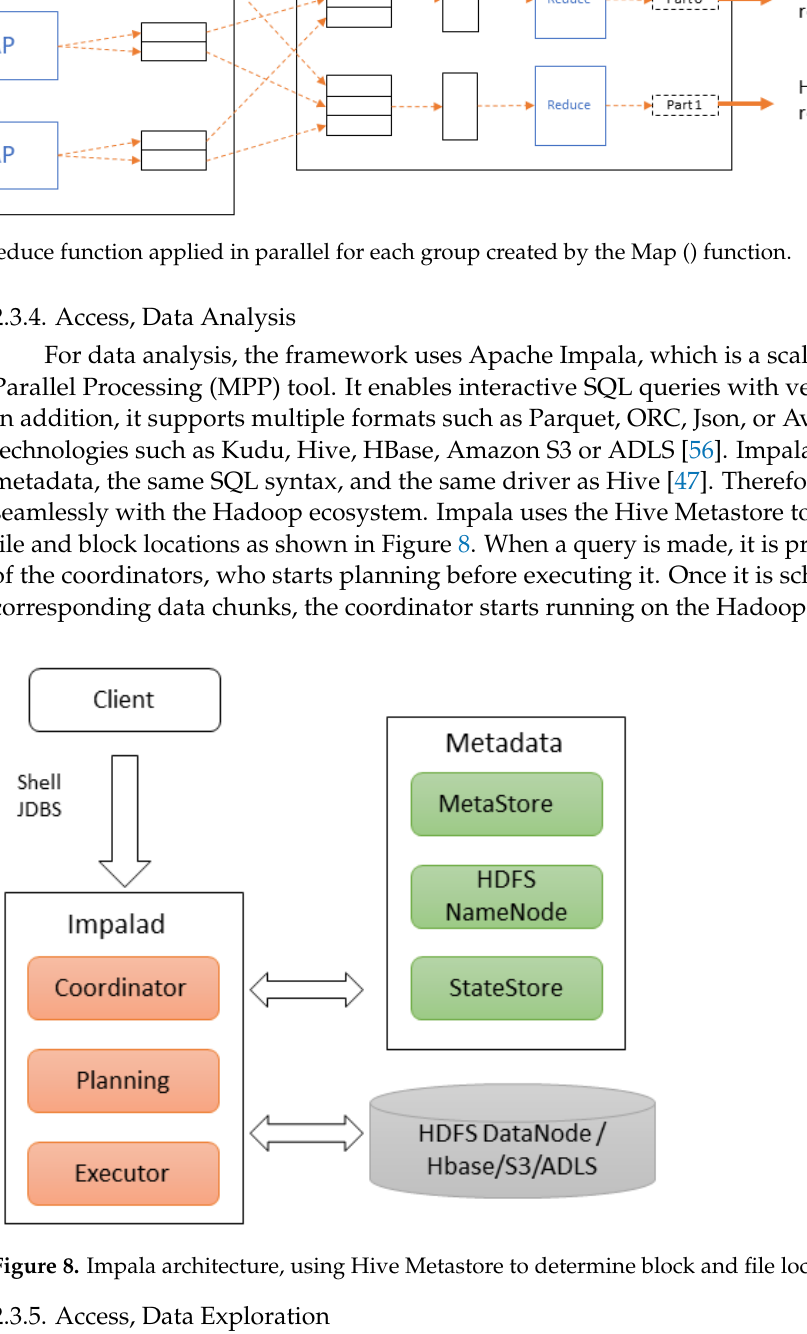
11 of 25 Figure 6. Map function, data entry, and block generation. The Reduce function is applied in parallel for each group created by the Map () func- tion. The Reduce function is called once for each unique key in the output of the Map function. Along with this key, a list of all the values associated with the key is passed so that you can perform some merging to produce a smaller set of the values. In Figure 7, the operation of the global MapReduce process is presented [55]. When the reduce task starts,